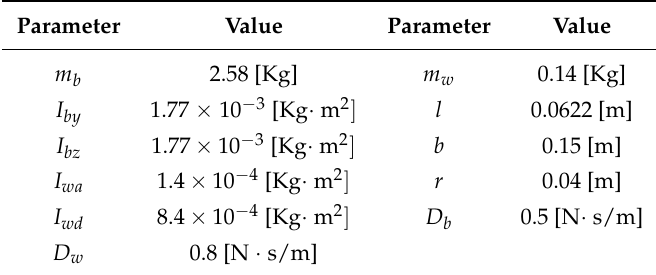
Table 1. Real parameters of the MWIP system.